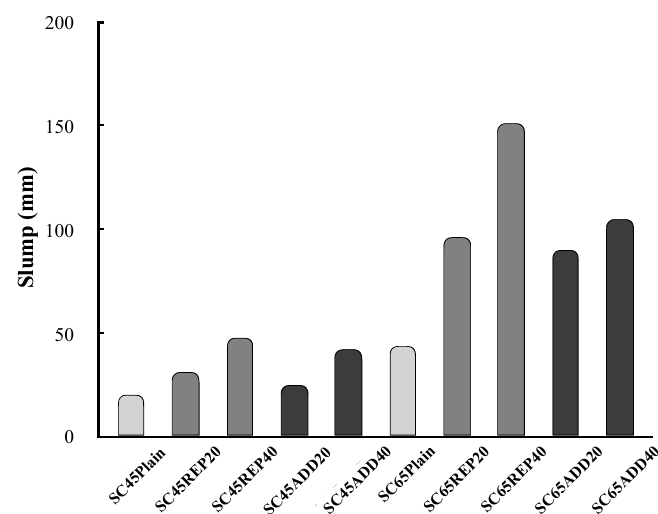
Figure 7. Slump of fresh concrete according to LRM mixing method